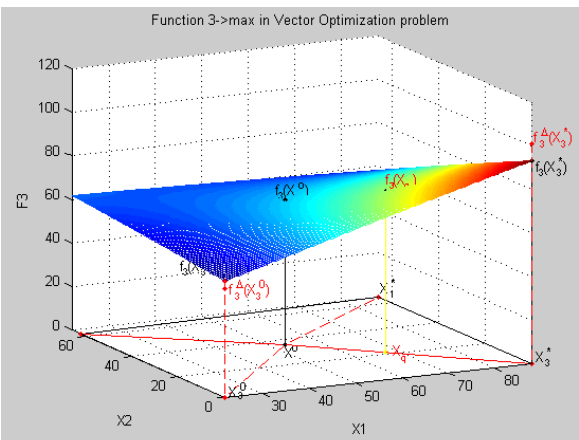
Figure 18. The third characteristic f3(X) of the system in a natural indicator.